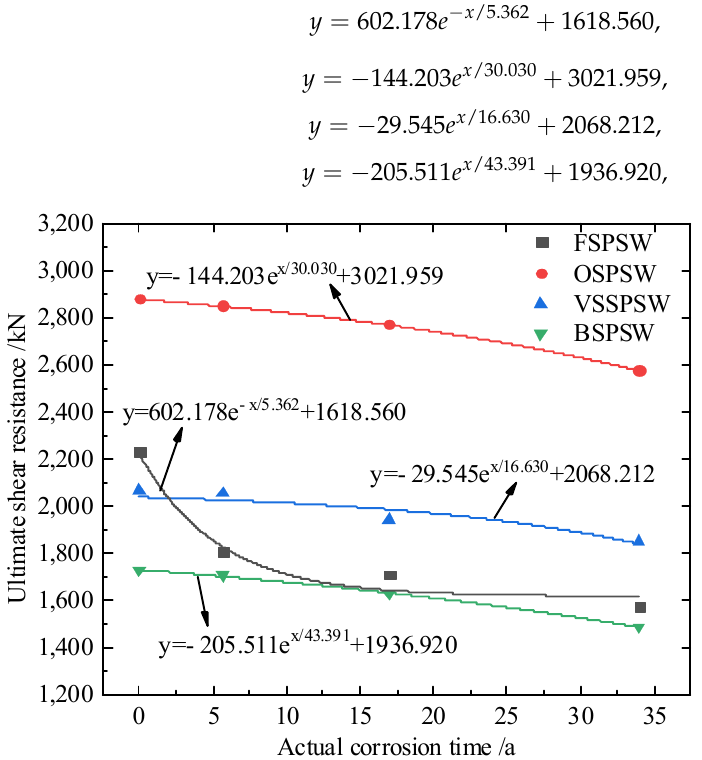
Figure 16. Fitting formulae of ultimate shearing resistance of